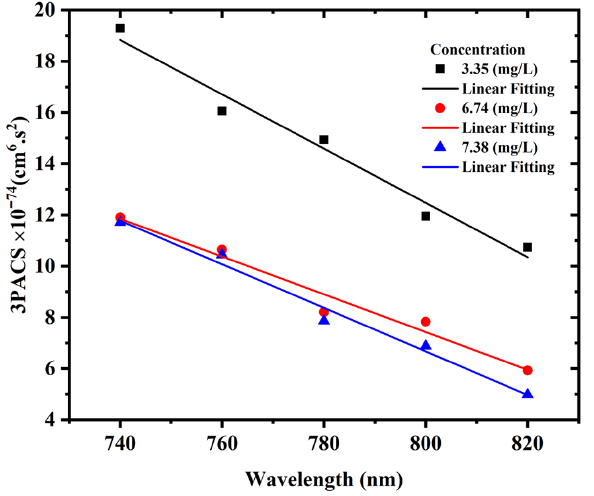
Figure 14. D ependency of three ‐ photon absorption cross ‐ section of AgNP colloids on excitation Figure 14. Dependency of three-photon absorption cross-section of AgNP colloids on excitation wavelength at constant AgNP concentrations and constant excitation power of 1 wavelength at constant AgNP concentrations and constant excitation power of 1 W.